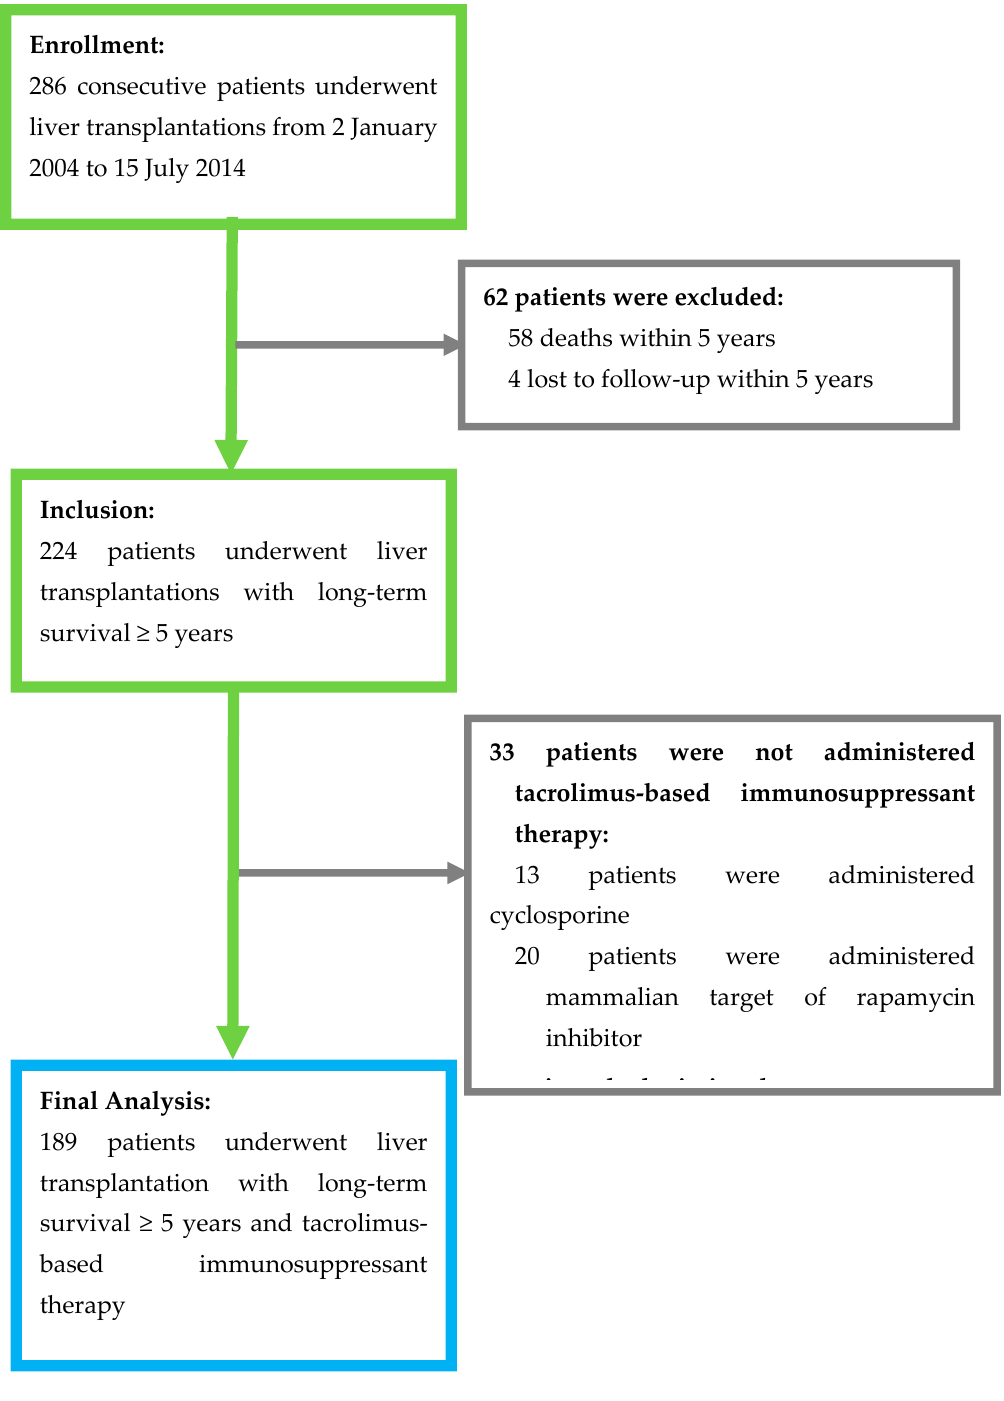
Figure 1. Patient flow diagram.